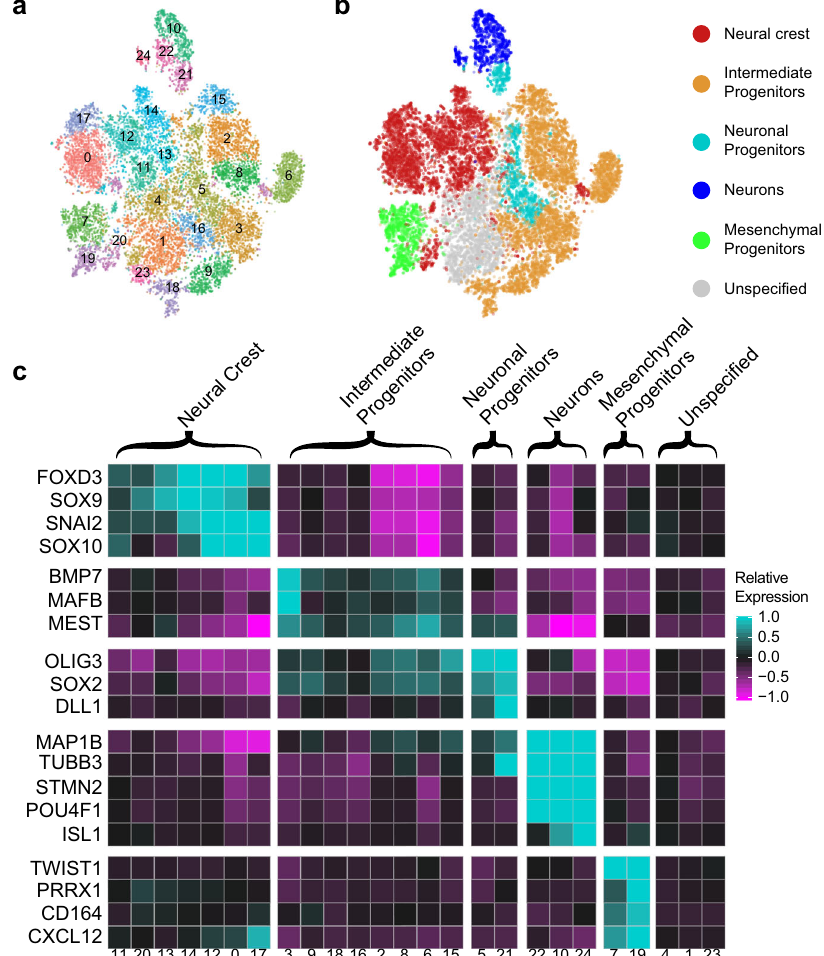
Fig. 2 Single-cell RNA-seq analysis of early organoids con fi rms multiple neural and mesodermal lineages. a Unsupervised cluster analysis of individual cells from early organoid cultures. Organoid cultures, three independent biological differentiation replicates of the control iPSC line 11a, were dissociated at 2 weeks in culture, and 20,835 single-cell libraries were sequenced at an average read depth of 35,000 reads/cell covering an average of 2555 unique genes/cell. The visualization shows tSNE plots of individual cells as dots and clusters of cells as colored groups. Numbers indicate cluster identity. b classi fi cation of clusters into six broad cell types. Marker genes for each cell cluster were identi fi ed, and clusters were then classi fi ed into groups accordingly. Clusters that could not be unambiguously identi fi ed are labeled as unspeci fi ed. The visualization shows the same tSNE plot from ( a ) recolored to re fl ect cell type. c Expression of cluster-de fi ning genes enriched in each cell type classi fi cation. Marker genes that are enriched in each cluster within a cell-type classi fi cation were identi fi ed. Note that the neural progenitor cell type was de fi ned by the presence of gene subsets from both the intermediate progenitor ( OLIG3 , SOX2 , and DLL1 ) and neuronal ( MAP1B , TUBB3 ) cell types. The plot shows the mean of scaled expression of indicated genes from within each cell cluster. High and low gene expression are indicated by cyan and magenta,